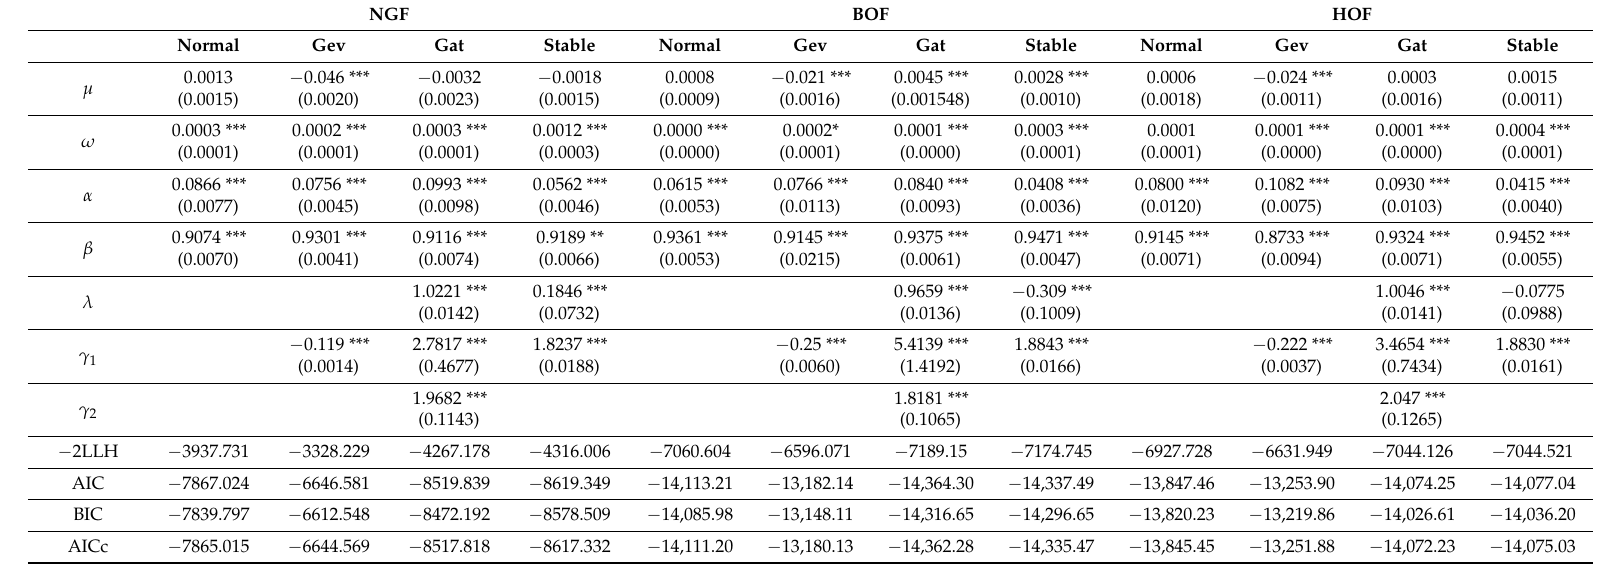
Table 4. GARCH (1.1)